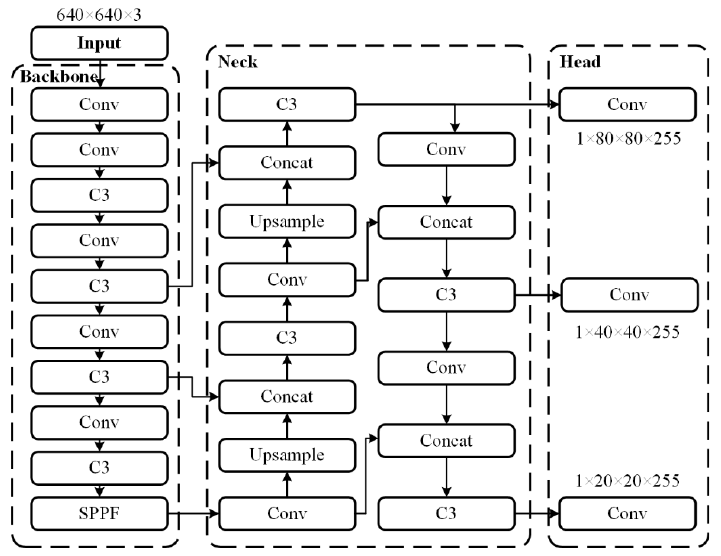
Figure 9. YOLOv5 network structure.